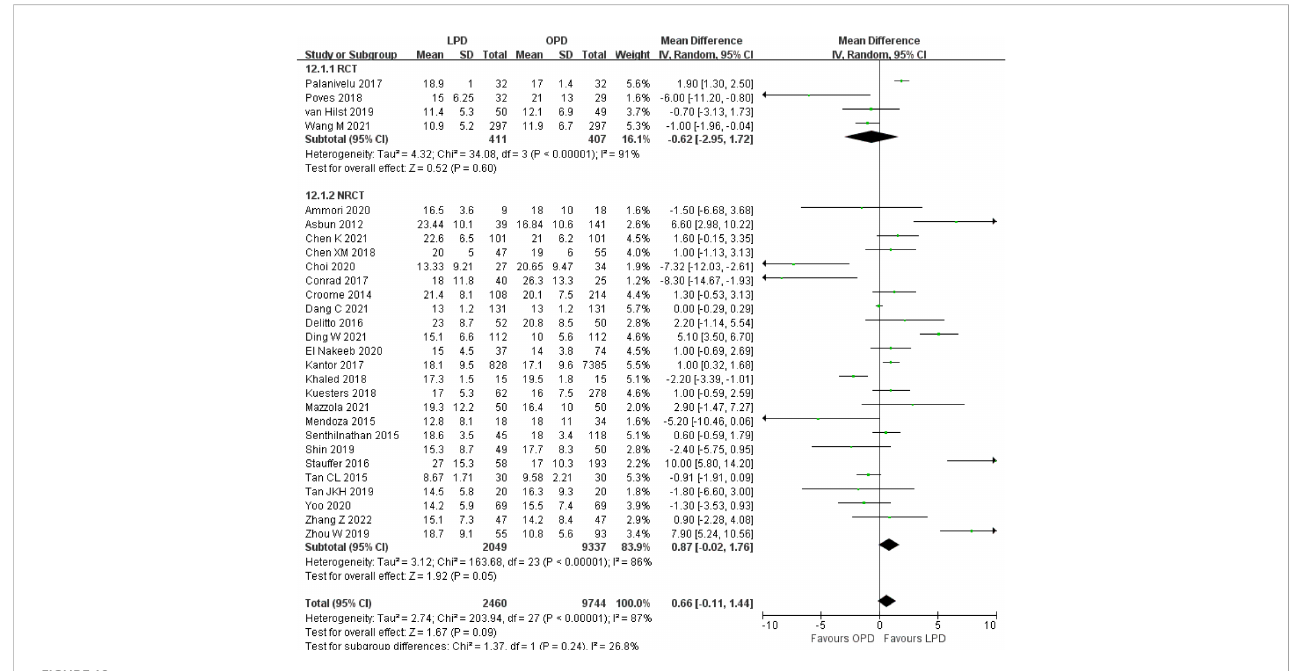
FIGURE 12 Forest plot of comparison between LPD and OPD on harvested lymph nodes. LPD, laparoscopic pancreaticoduodenectom; OPD, open